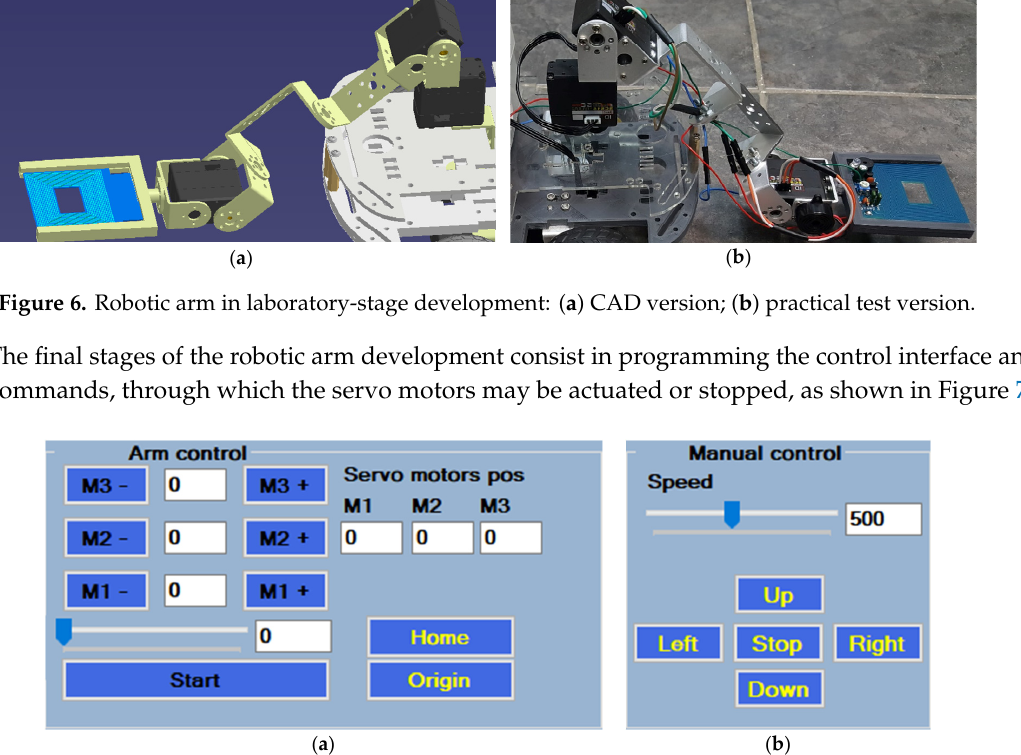
Figure 7. Configuring the control panel: ( a ) robotic arm control with servo motors; ( b ) manual control. The general interface developed in a Microsoft package with Visual Studio is shown in Figure 8.